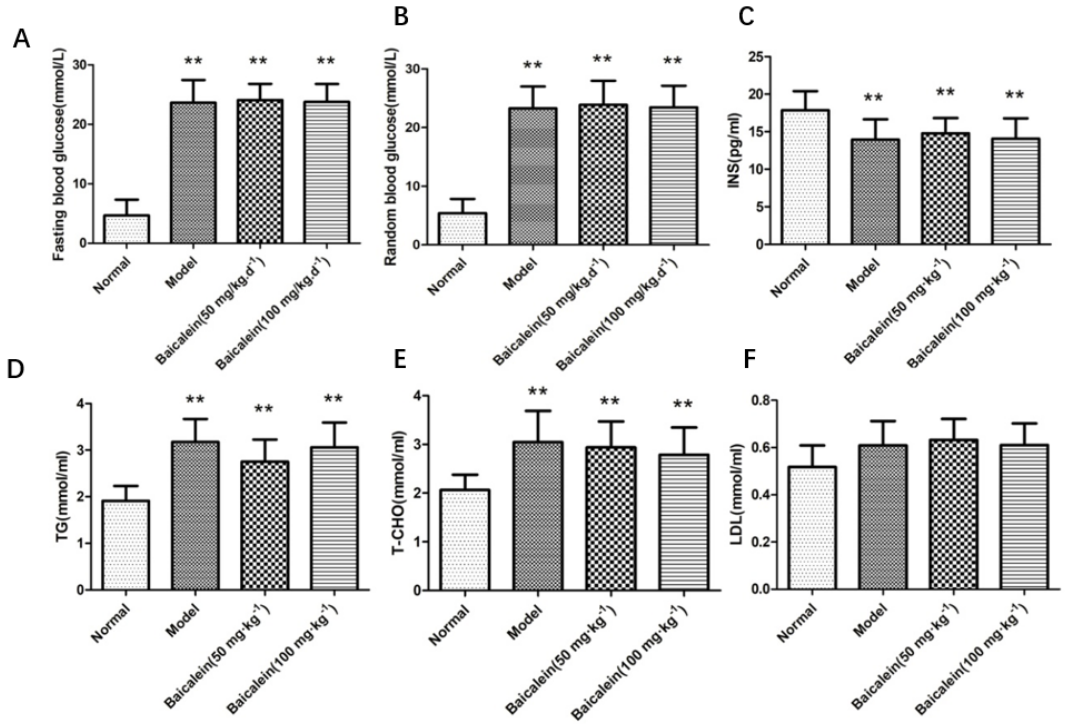
Figure 2. The establishment of diabetes model. Fasting blood glucose level ( A ). Random blood glucose level ( B ). Insulin level ( C ). TG level ( D ). T − CHO level ( E ). LDH level ( F ). ** p < 0.01 compared with normal group.